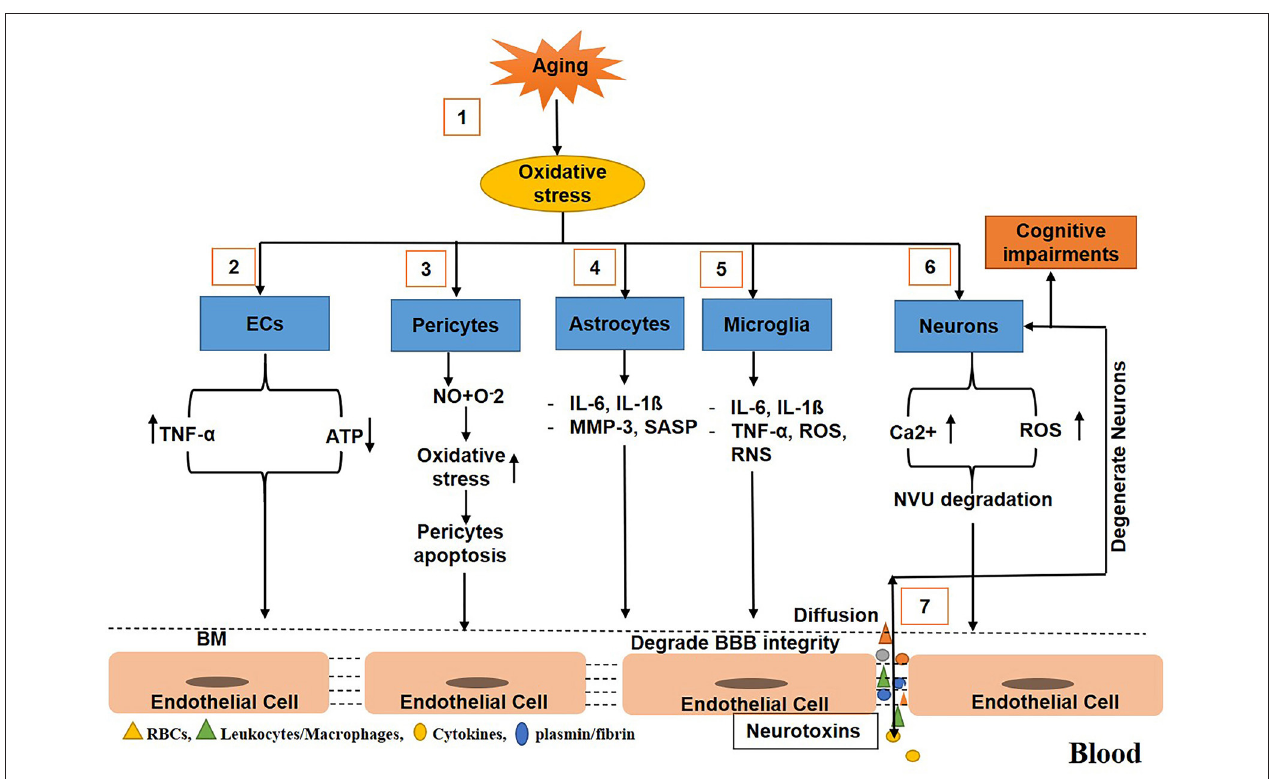
FIGURE 2 | Schematic diagram shows the mechanisms of blood–brain barrier (BBB) breakdown in normal aging. (1) Oxidative stress increases with age. (2) Oxidative stress triggers endothelial cells ECs to release tumor necrosis factor- α (TNF- α ) and consume more ATP. (3) Oxidative stress induces pericytes to release nitric oxides that react with reactive oxygen to further upregulate the oxidative stress causing pericytes apoptosis associated with loss in BBB integrity. (4) During aging, oxidative stress stimulates and activates astrocytes to release cytokines and chemokines that degrade the basement membrane and tight junction leading to BBB impairment. (5) Oxidative stress also activates the microglia to secrete cytokines, chemokines, reactive oxygen, and nitrogen species, causing degradation in BBB integrity. (6) Oxidative stress also induces neurons to release reactive oxygen species (ROS) and calcium ions accumulation that cause to degrade the neurovascular unit (NVU). (7) Toxins freely diffuse to and from the brain, causing neurodegeneration and decline in